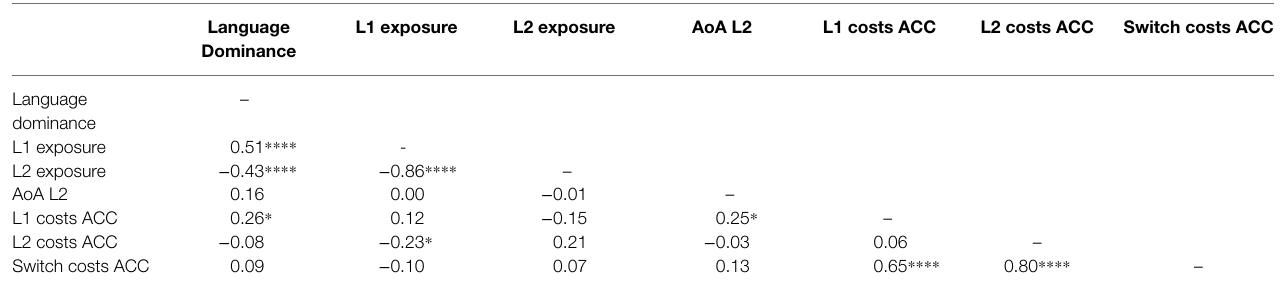
TABLE 7 | Bilinguals’ Pearson correlation analyses between Language Dominance, recent exposure, initial age of L2 acquisition (AoA L2) and switching performance in the picture naming task in terms of accuracy rates